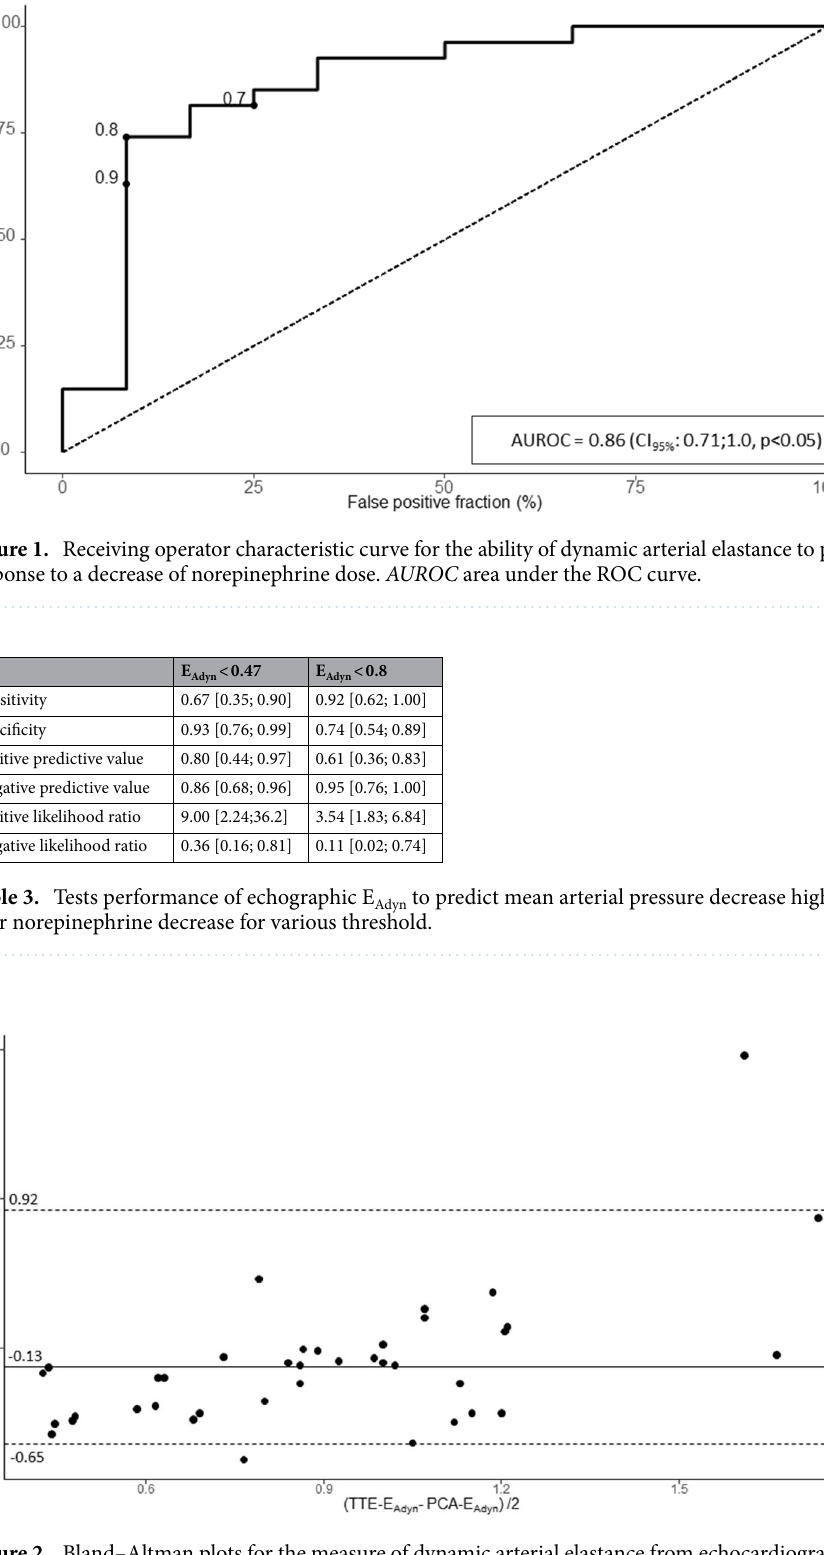
Figure 2. Bland–Altman plots for the measure of dynamic arterial elastance from echocardiography and from pulse contour analysis (transpulmonary thermodilution). The plain lane represents the median, dashed lines represent the 2.5th and 97.5th percentiles. TEE- EAdyn dynamic elastance calculated from transthoracic echocardiography, PCA- EAdyn dynamic elastance calculated from pulse contour